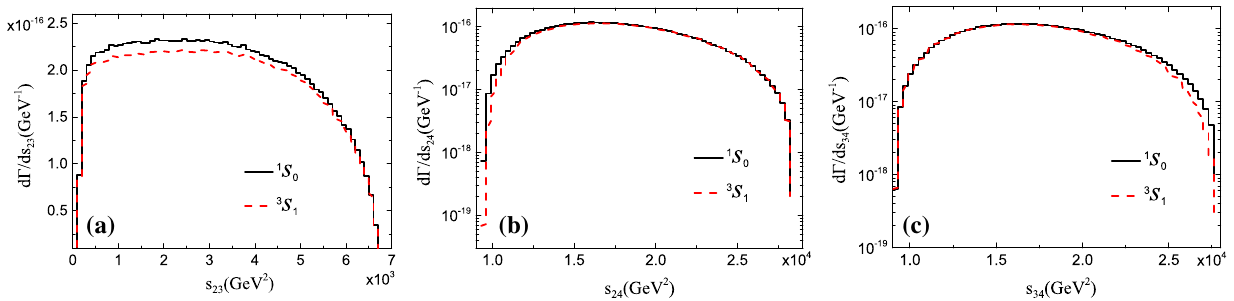
Fig. 6 The Feynman diagrams for t ( p 1 ) → | ( c ¯ b ) [ n ](cid:5) ( p 2 ) + b ( p 3 ) + Z 0 ( p 4 ) without FCNC, where n stands for the two color-singlet S -wave states